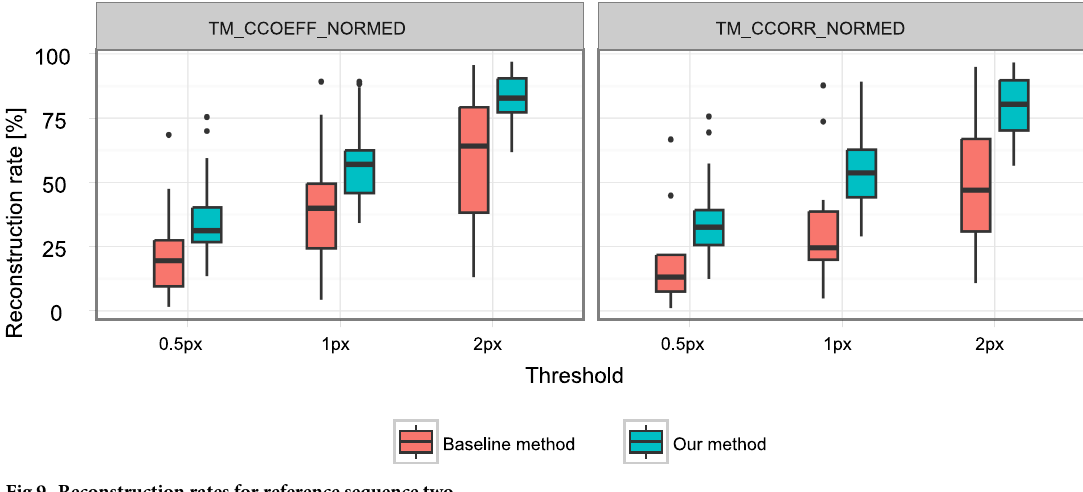
Fig 9. Reconstruction rates for reference sequence two.